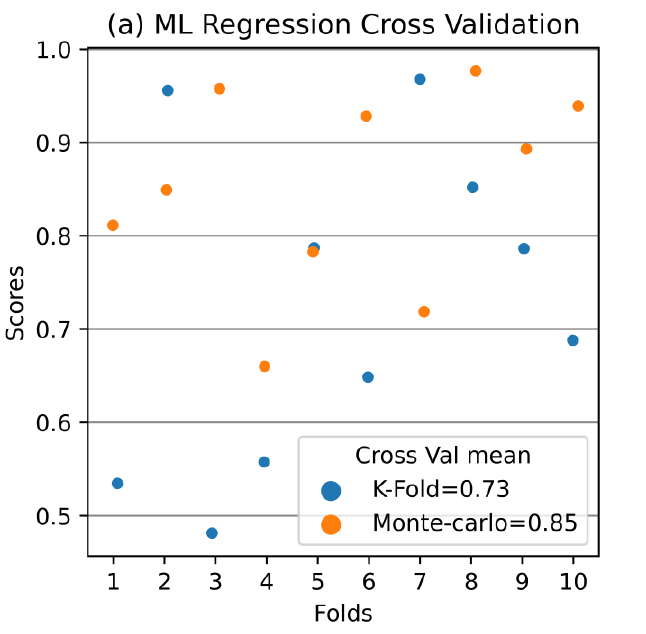
Table 3. Evaluation Metric Scores of the Models.